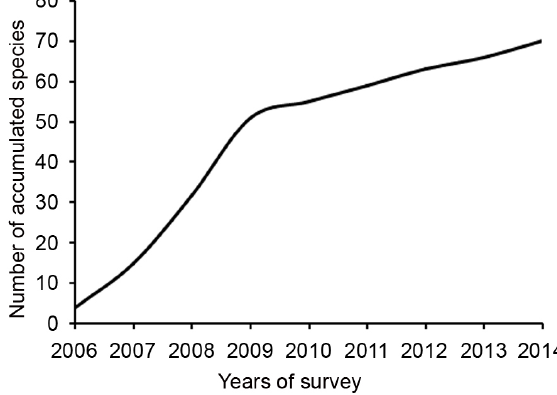
Figure 3. Species accumulation curve of the butterflies in and around RRS, Chinsurah.